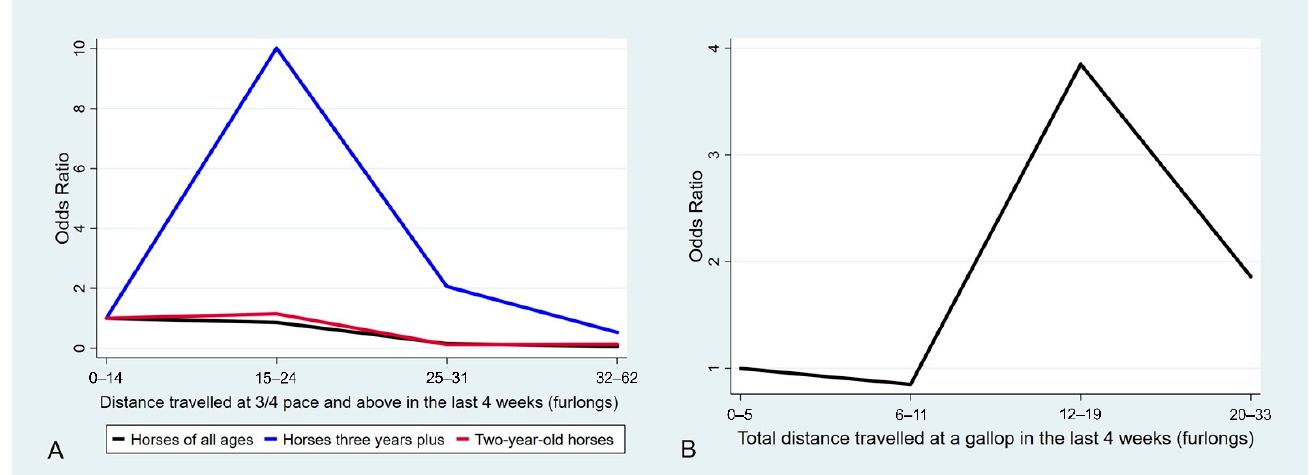
Figure 1. The effect of high-speed exercise history on musculoskeletal injury in Thoroughbred racehorses in South-East Queensland, Australia. ( A ) The effect of increasing distance travelled at three-quarter pace and above (faster than 13 m/s; 15 s/furlong; 800 m/min; 48 km/h) on musculoskeletal injuries (MSI) in horses of all ages, two-year-old horses and horses three years and older. ( B ) The effect of increasing distance travelled at a gallop (faster than 15 m/s; 13 s/furlong; 900 m/min; 55 km/h) on MSI in horses of all ages. Results shown are from multivariable conditional logistic regression analyses for 202 cases of musculoskeletal injury and 202 controls matched by trainer and age. Significance was set at α = 0.05.